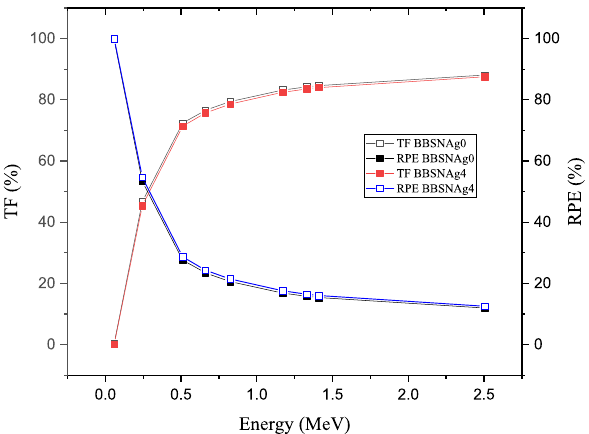
Figure 14. Variation of the Transmission factor (TF, %) and the radiation protection efficiency (RPE, %) versus gamma-ray energies for samples BBSNAg0 and BBSNAg4.